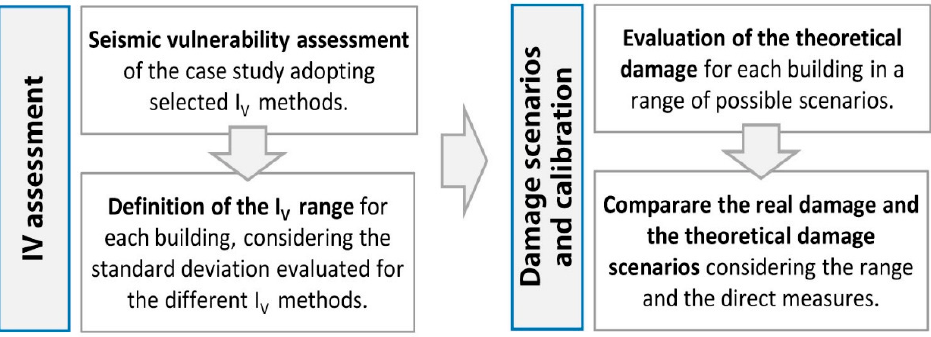
Figure 12. Procedure adopted to evaluate the reliability of vulnerability assessment methods. Table 6. Evaluation of the Iv method reliability in the case study analysed. I V Method Accuracy (Direct